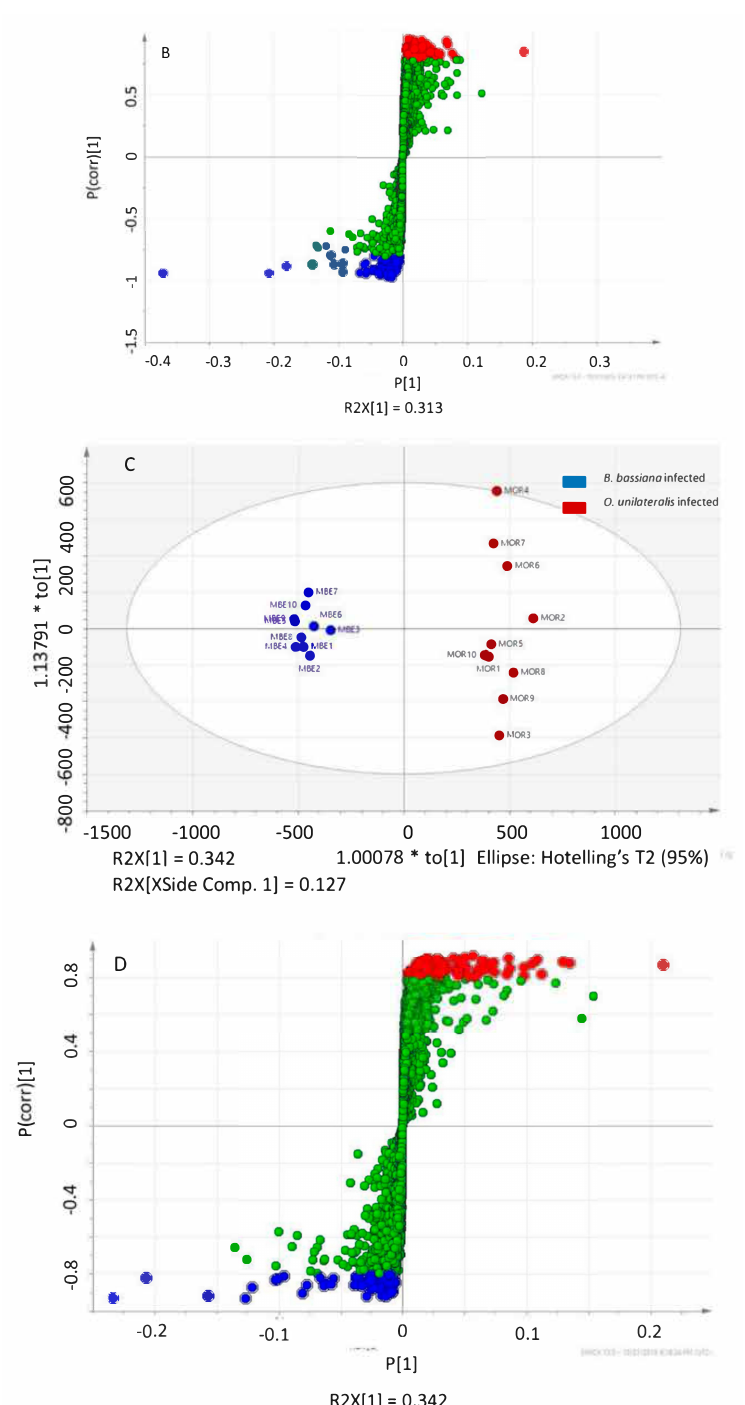
Figure 3. Di ff erential metabolic profiles in muscle between Beauveria bassiana - and Ophiocordyceps unilateralis -infectedants. ( A )OPLS-DAscoreplotseparating B.bassiana -infected(blue)and O.unilateralis - infected (red) samples from positive ion feature data. ( B ) S-plot analysis of all B. bassiana -infected samples against O. unilateralis ants’ samples from positive ion feature data. ( C ) OPLS-DA score plot separating B. bassiana -infected (blue) and O. unilateralis -infected (red) samples from negative ion feature data. ( D ) S-plot analysis of all B. bassiana -infected samples against O. unilateralis -infected ants’ samples from negative ion feature